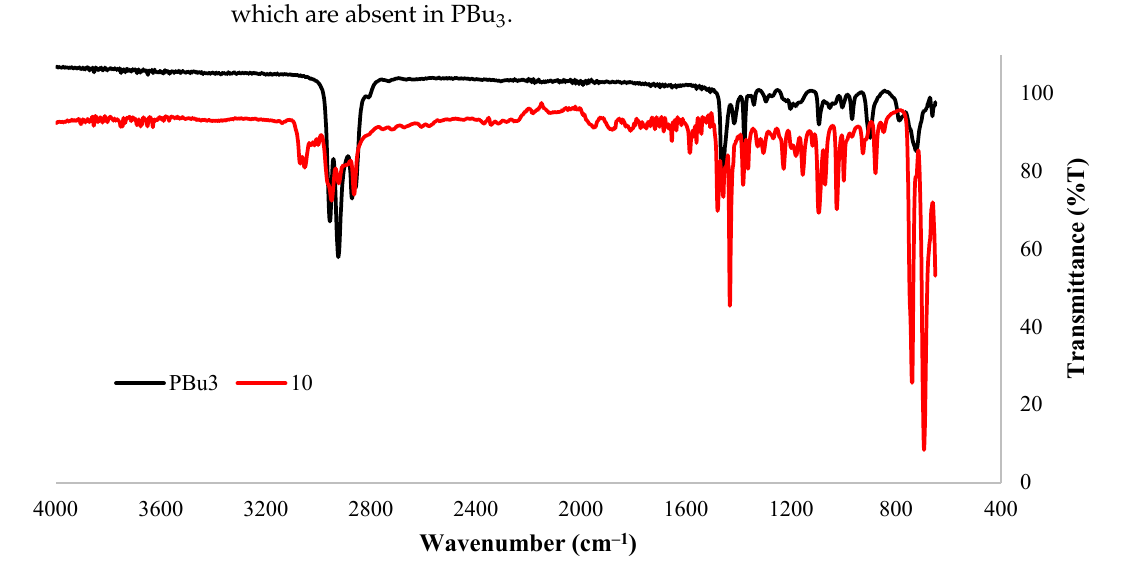
Figure 5. IR (ATR) spectra of compound ( 10 ) and tributylphosphine (PBu 3 ). The UV–Vis spectra of isopentyldiphenyl phosphine ( 5 ), diisopentyl(phenyl)phosphine ( 10 ), and a commercially available tributylphosphine (PBu 3 ) were recorded in acetonitrile (Figure 6). Bands can be seen in the spectra in the expected positions. For instance, PBu 3 exhibits high energy absorption maxima at 216 nm, while ( 10 ) shows maxima at 220 nm, along with a low-energy broad band in the region of ~260–270 nm with vibronic features. Similar, but slightly redshifted peaks can be seen in ( 5 ), owing to the presence of two phenyl groups. Note that ( 5 ) and ( 10 ) bear the features of the PBu 3 , methyldiphenyl phosphine, and triphenylphosphine [28]. While the high energy transition in PBu 3 can be attributed to n → σ * transition, the absorption in the latter compounds (i.e., 5 and 10 ) is due to n → π * transitions. This assignment is consistent with the theoretical calculations (vide infra) [29].